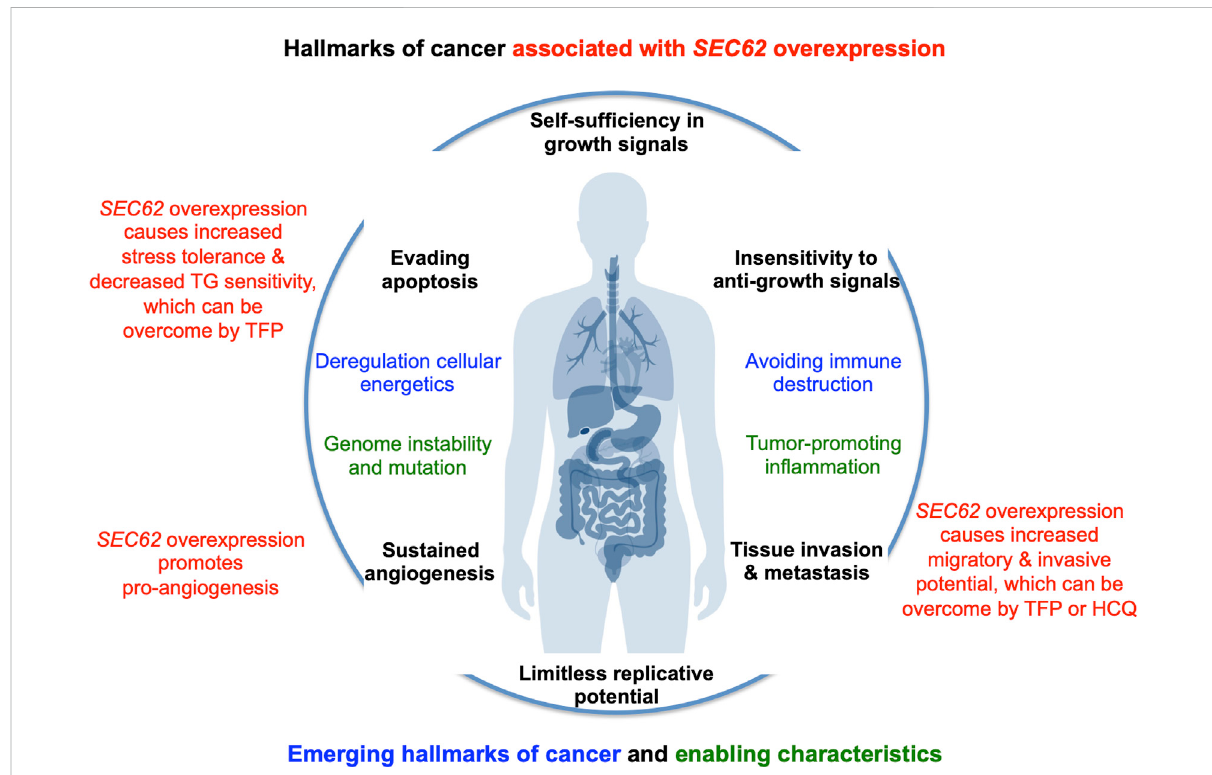
FIGURE 4 SEC62 overexpressingtumorcellsarecharacterizedbyincreasedstresstoleranceandincreasedmigratoryandinvasivepotential,twohallmarks of cancer. The hallmarks of cancer and enabling characteristics were described in seminal papers by Hanahan and Weinberg (Hanahan and Weinberg, 2000; Hanahan and Weinberg, 2011). The red texts refer to the hallmarks that are linked to SEC62 overexpressing cancer cells (Greiner et al., 2011a; Greiner et al., 2011b; Linxweiler et al.,